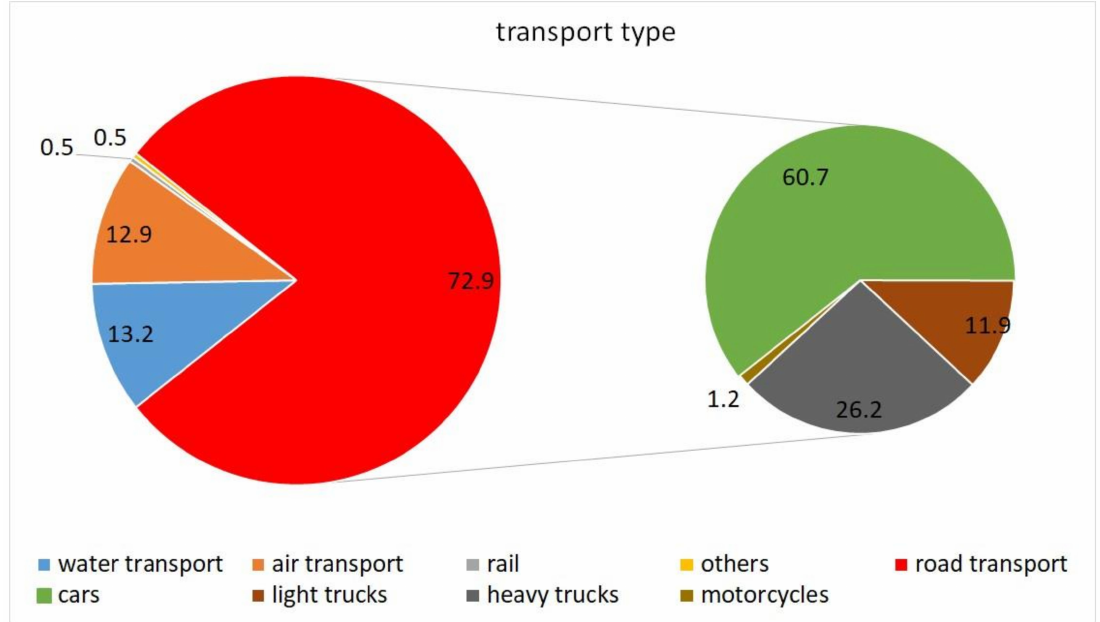
Figure 1. Distribution of CO 2 emissions in the transport sector and distribution of emissions in road transport (own drawings based on